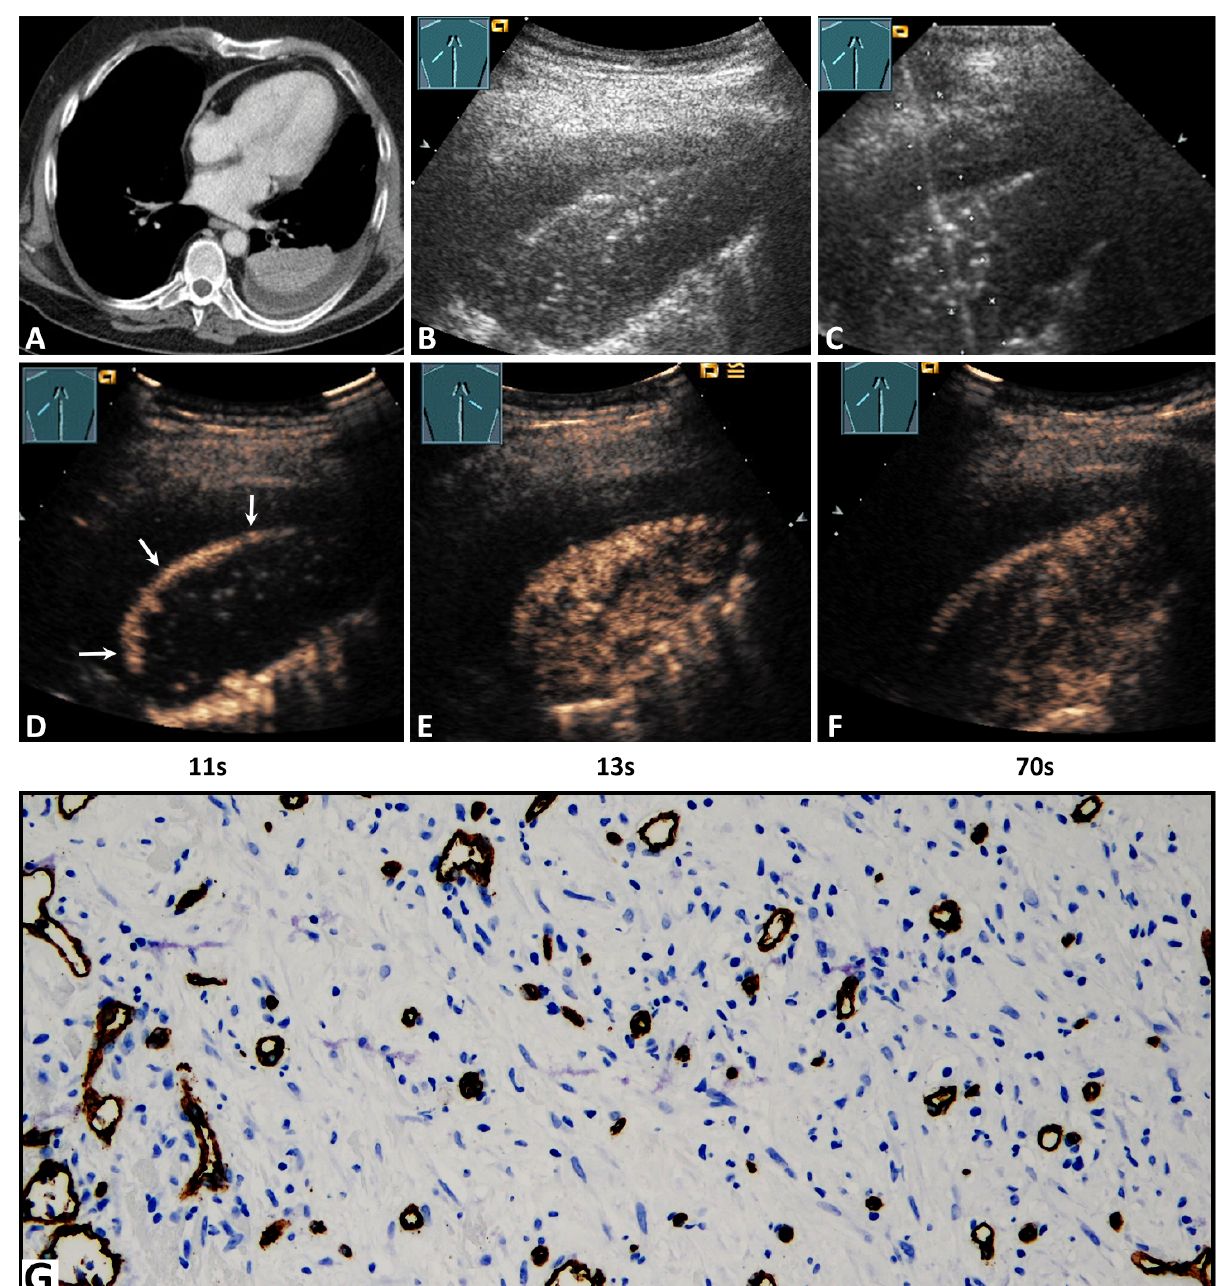
Figure 2. A 62-year-old male patient with lung consolidation on ( A ) computed tomography (courtesy of Prof. Dr. Andreas H. Mahnken, Department of Radiology, University Hospital Marburg) and ( B ) B-mode ultrasound. ( C ) An